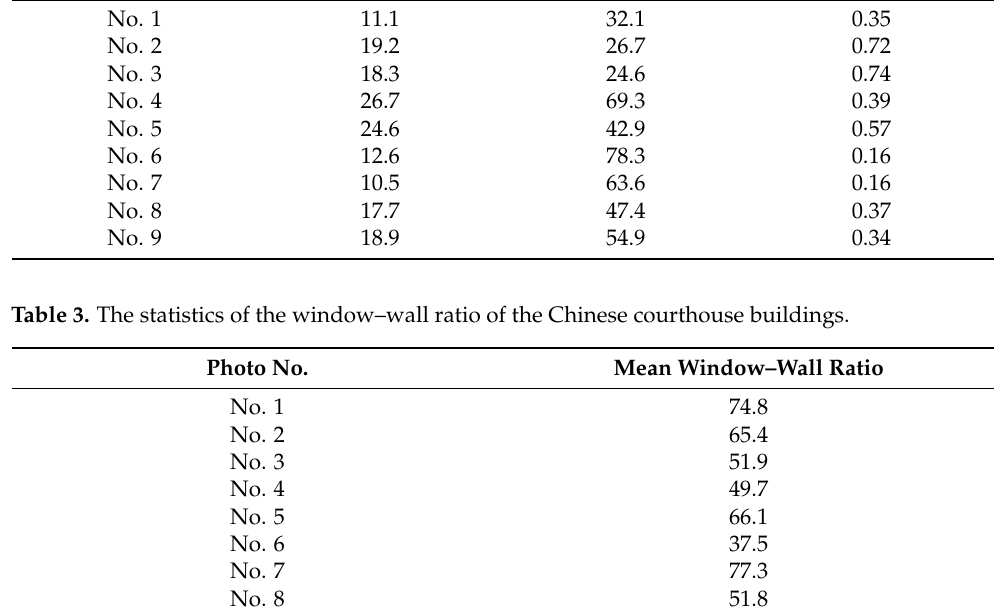
Figure 2. Schematic diagram of the height–width ratio calculation. Table 2. The statistics of the height–width ratio of the Chinese courthouse buildings. Photo No. The Length of A (m) The Length of B (m)